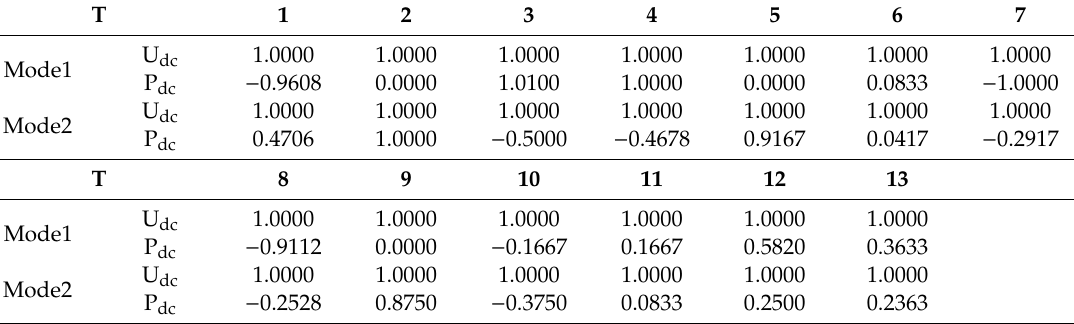
Table A6. The initial nodal voltage and active power reference of the 13-terminal VSC-MTDC system